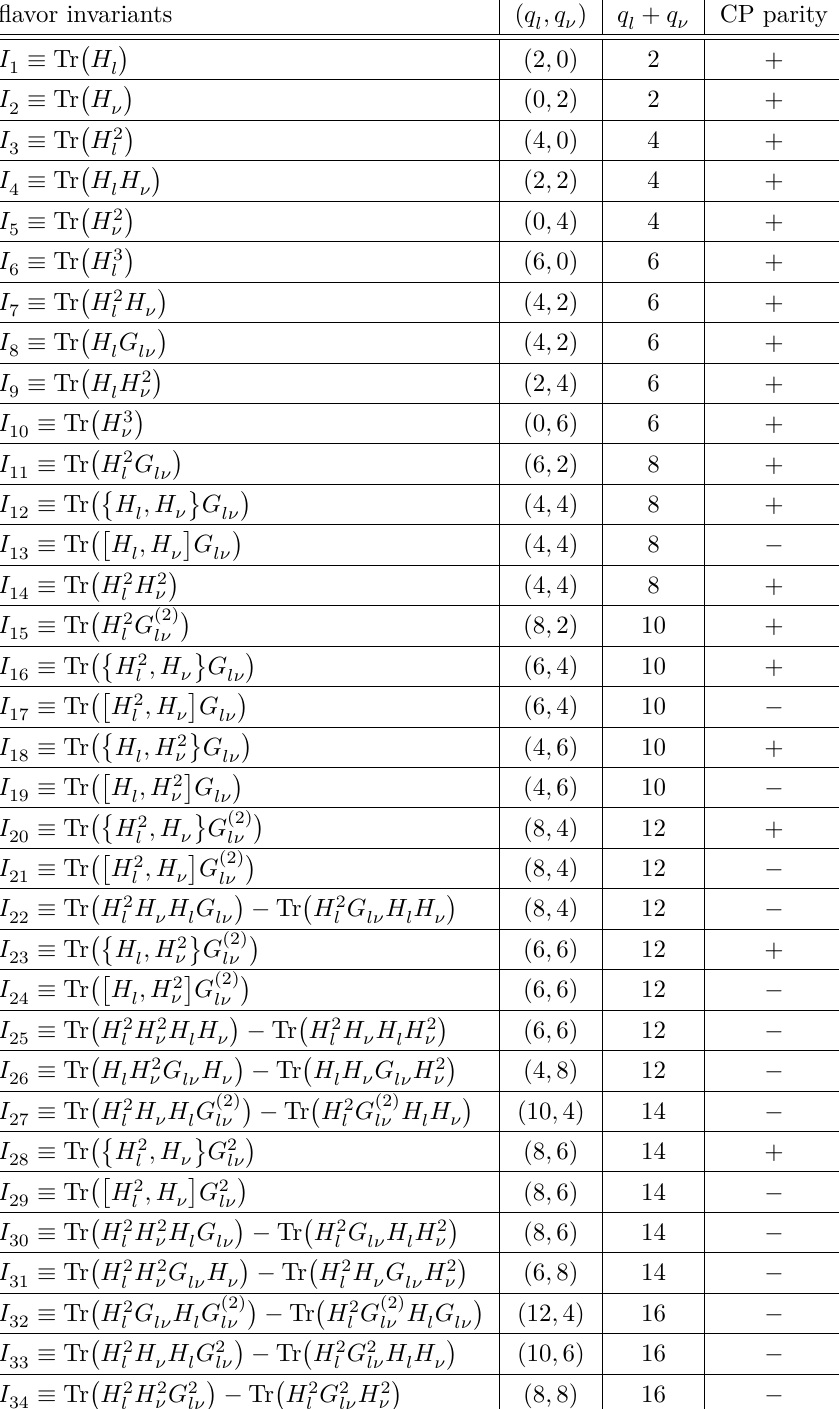
Table 2 . Summary of the basic flavor invariants in the generating set along with their degrees and CP parities in the three-generation case, where q respectively. Note that the commutator [ A, B ] ≡ AB − BA and the anti-commutator { A, B } ≡ AB + BA of two matrices have been